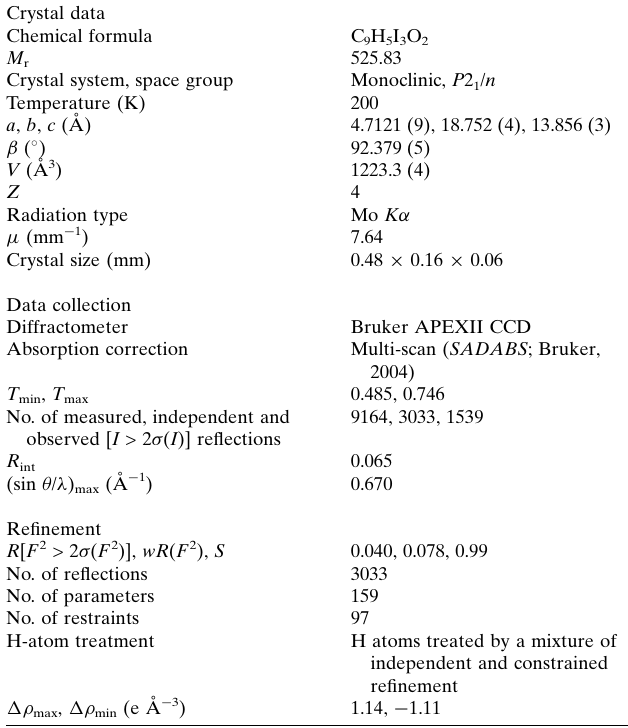
Table 3 Experimental